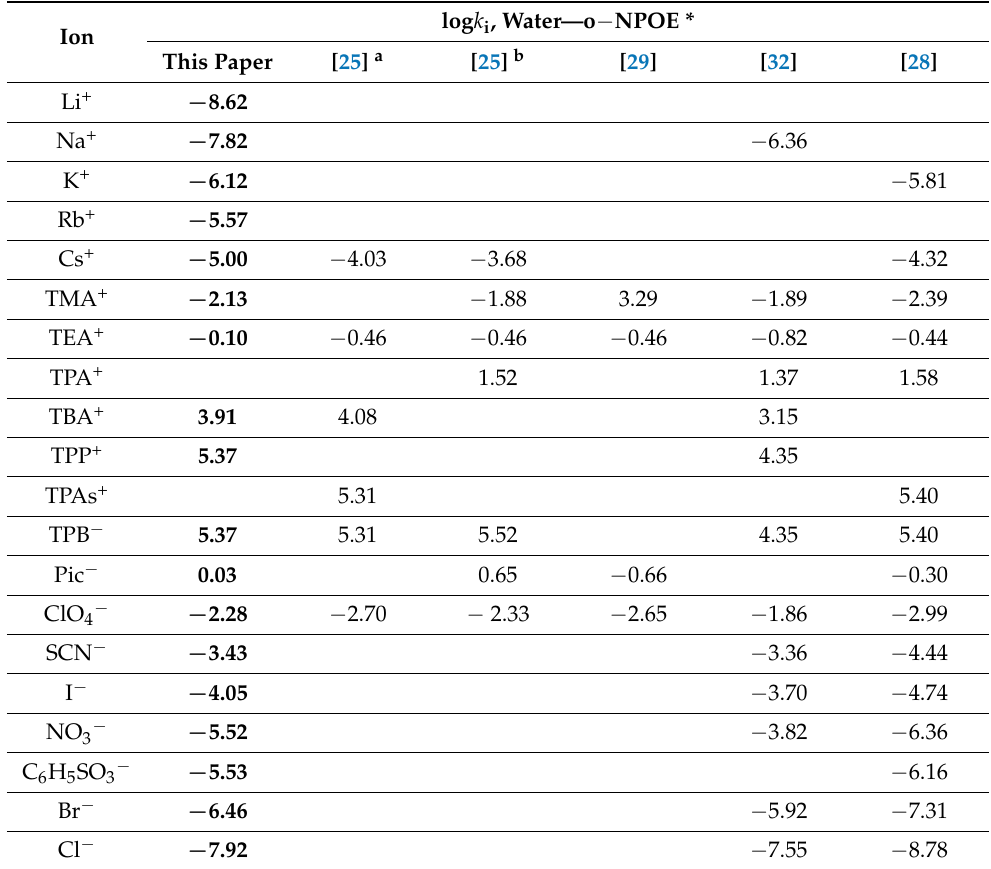
Table 2. The single-ion partition coefficients from water to o-NPOE-PVC membrane (this paper, in bold) and to o-NPOE (literature